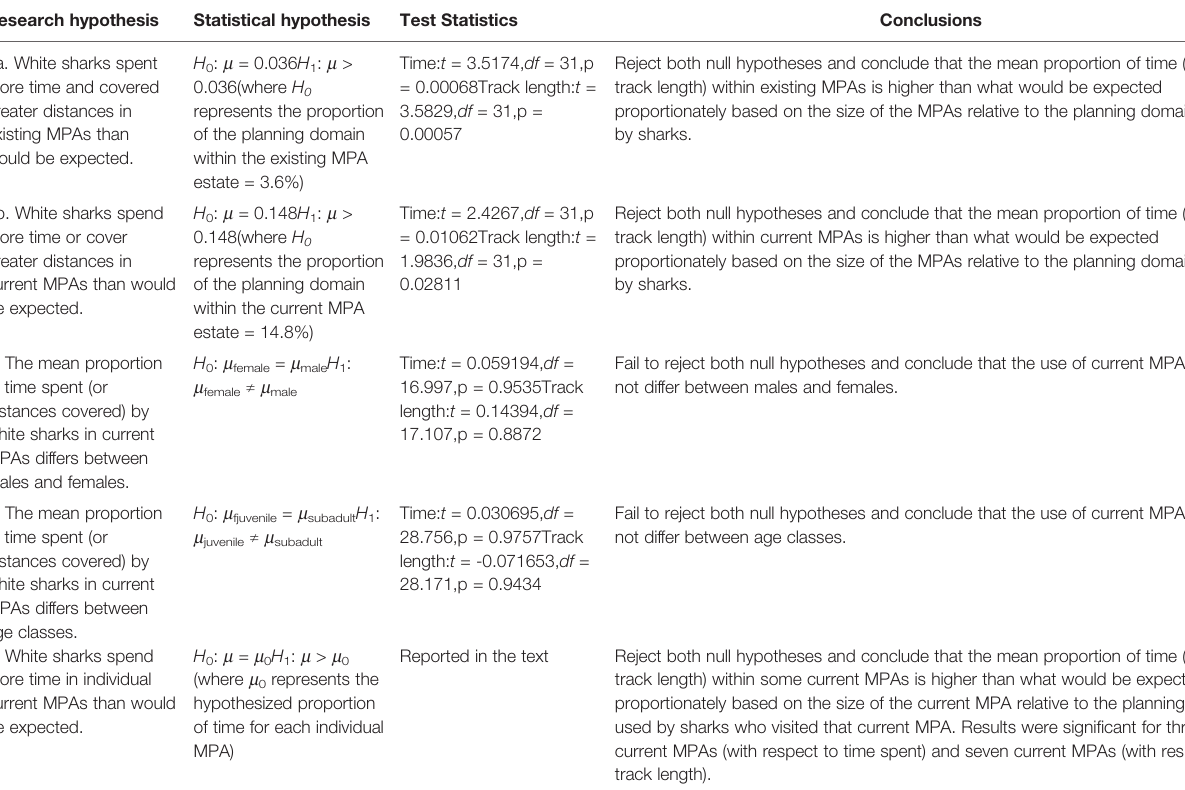
TABLE 4 | Research hypotheses and results of white shark Carcharodon carcharias use of marine protected areas (MPAs) using time spent and track length.